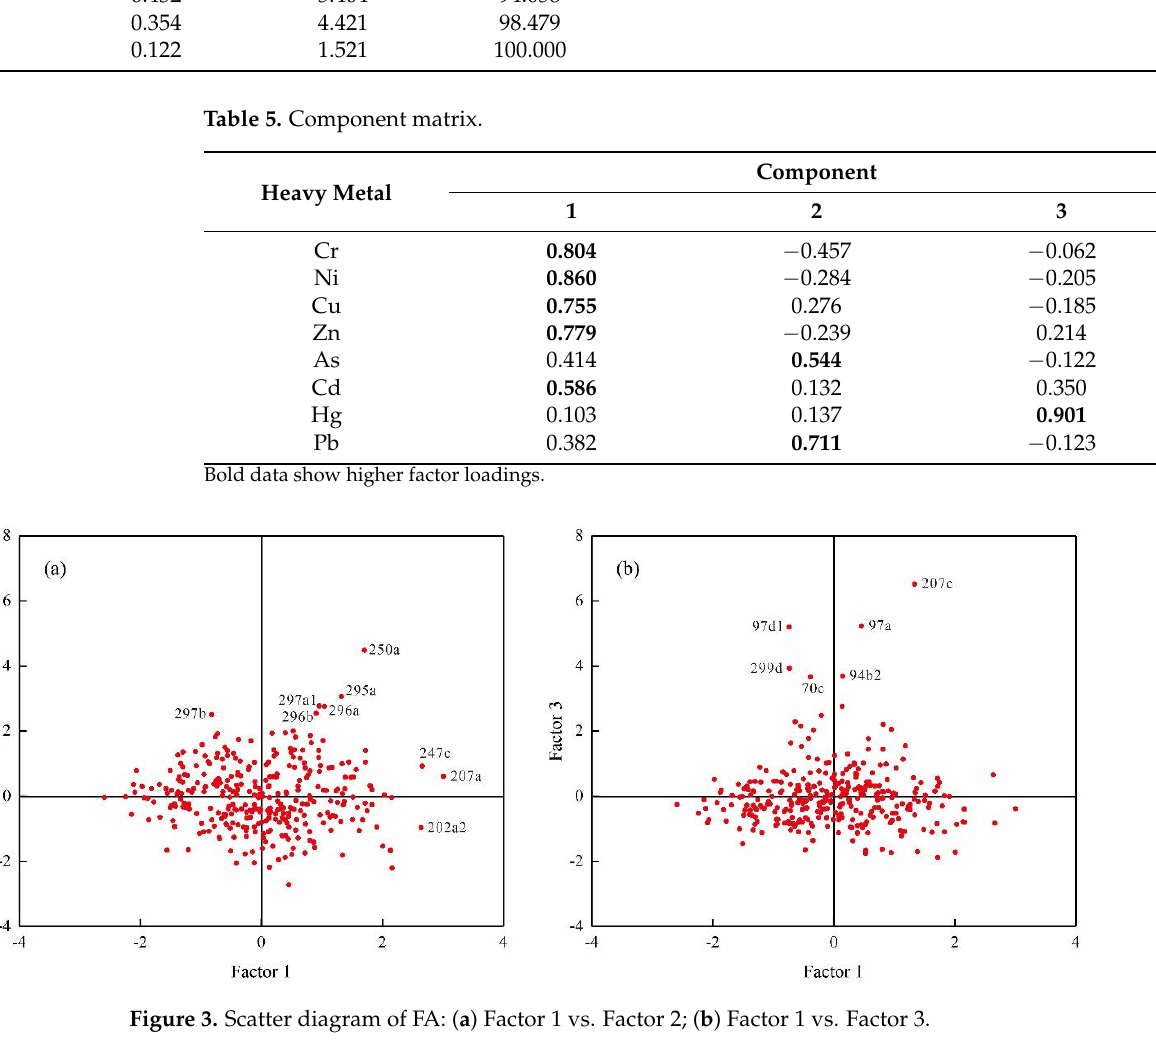
Figure 4. Dendrogram of HCA. 3.2. Average Concentration of Heavy Metals in Ginger and Root–Soil When the concentration of heavy metals in animals and plants exceeds a certain threshold, they cause harm. In particular, heavy metals enter the human body through the food chain and accumulate continuously, increasing the risk of cancer and other dis- eases. Therefore, it is important to study the content characteristics of heavy metals in crops. Such studies would contribute towards controlling the quality of crops, as well as characterizing the absorption intensity of heavy metals in soil by crops. The average concentrations of heavy metals in ginger followed the order: Zn > Cu > Ni > Cr > Pb > As > Cd > Hg (Table 6). Hg was not detected in the samples. Half of the detection limit was used for statistics. The CV values of Zn and As were 0.26 and 0.31,